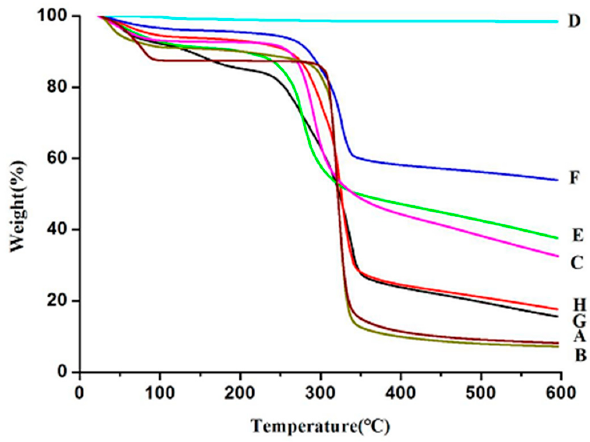
Figure 5. Thermogravimetric analysis (TGA) spectra of different materials. A: β -CD; B: GEO/ β -CD composite; C: Chitosan; D: STPP; E: Physical mixture (with STPP); F: GEO/ β -CD/CTS particles; G: Physical mixture (without STPP); H: GEO/ β -CD/CTS microsphere.